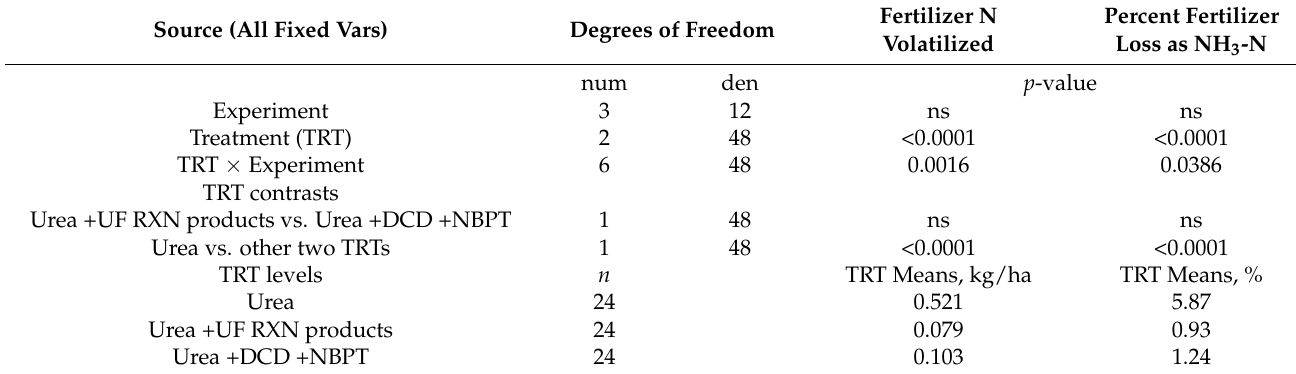
Table 2. Analysis of variance (ANOVA) of 0- to 24 h fertilizer N volatilized (kg/ha) and percent fertilizer loss as NH 3 -N (%), by